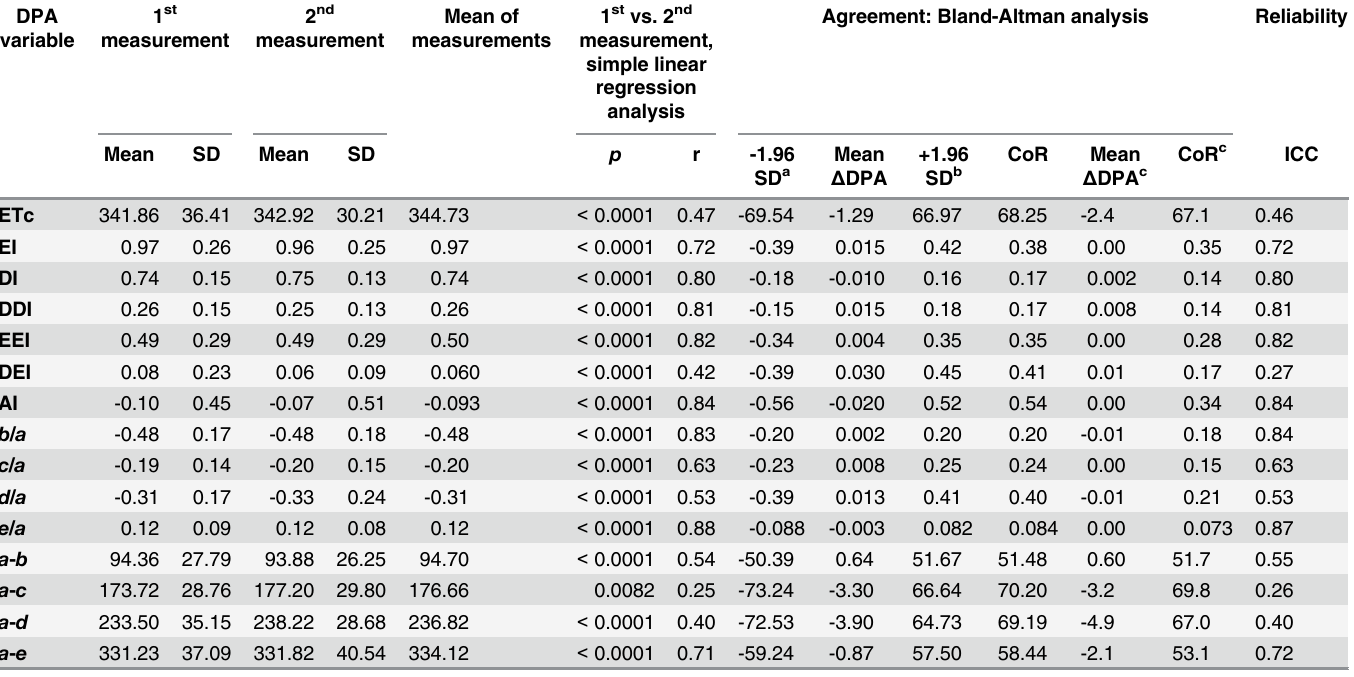
Table 2. Measures of agreement and reliability between two repeated measurements of digital pulse analysis (DPA) variables in 112 individuals. For explanation of DPA variables, see